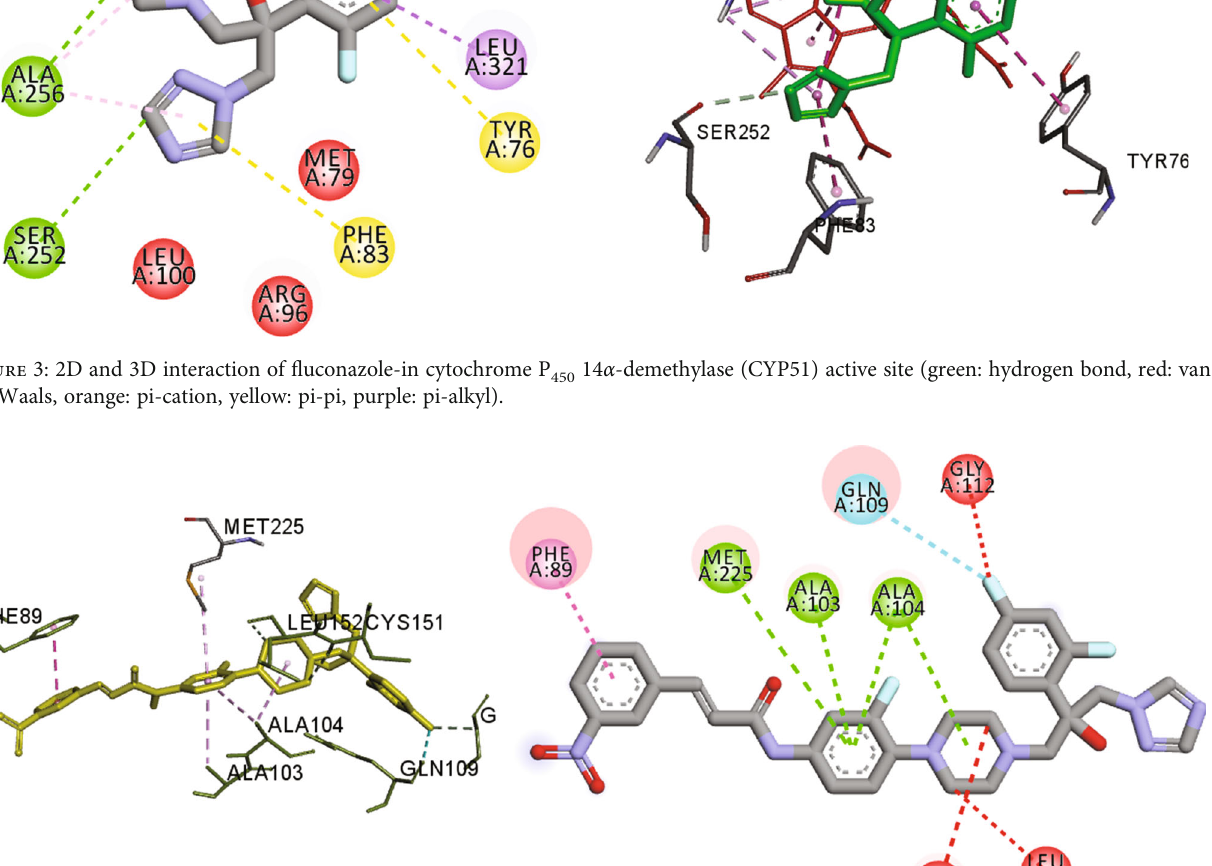
14 α -demethylase (CYP51) active site (green: hydrogen bond, blue: 450